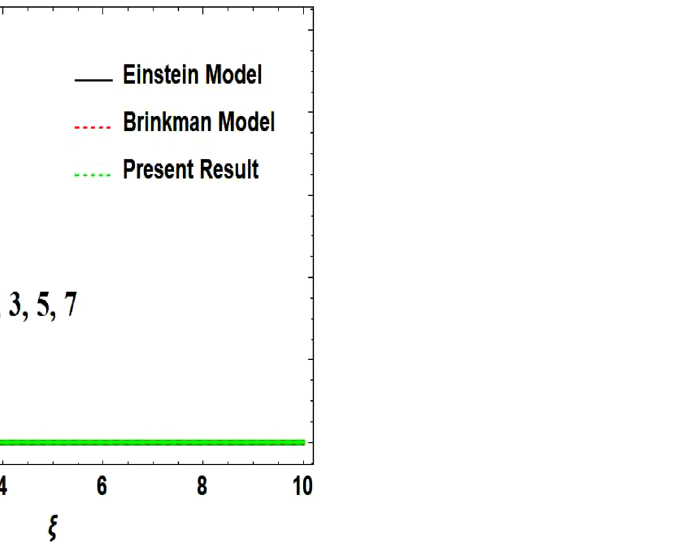
Figure 6. Temperature curve influenced by Prandtl